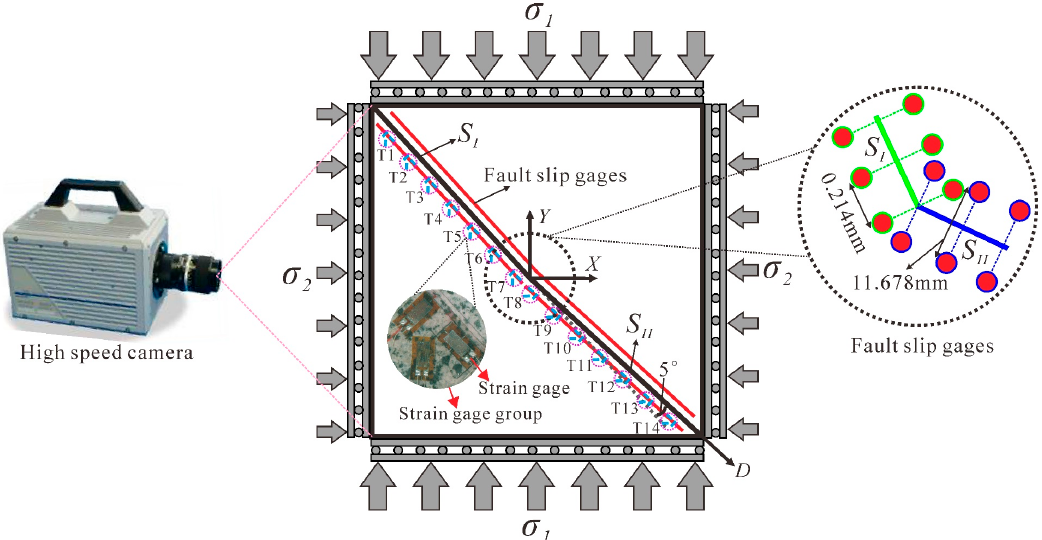
Figure 1. Experimental design. The field of view of the high-speed camera covers the entire sample surface. The D -axis coincides with the fault trace. The common origins of the D -, X -, and Y -axis coincide with the bend point of the fault. The fault is divided into segments S I and S II . The red lines on both sides of the fault are each composed of 1700 measuring points (pixels), which are symmetric with the fault and offset 5.839 mm from the fault. T1–T14 are the numbers of 14 strain gage groups mounted along the fault on the bottom sample surface. The inset pointing to the T5 strain gage group shows details of the arrangement of the three strain gages forming the strain gage group on the sample